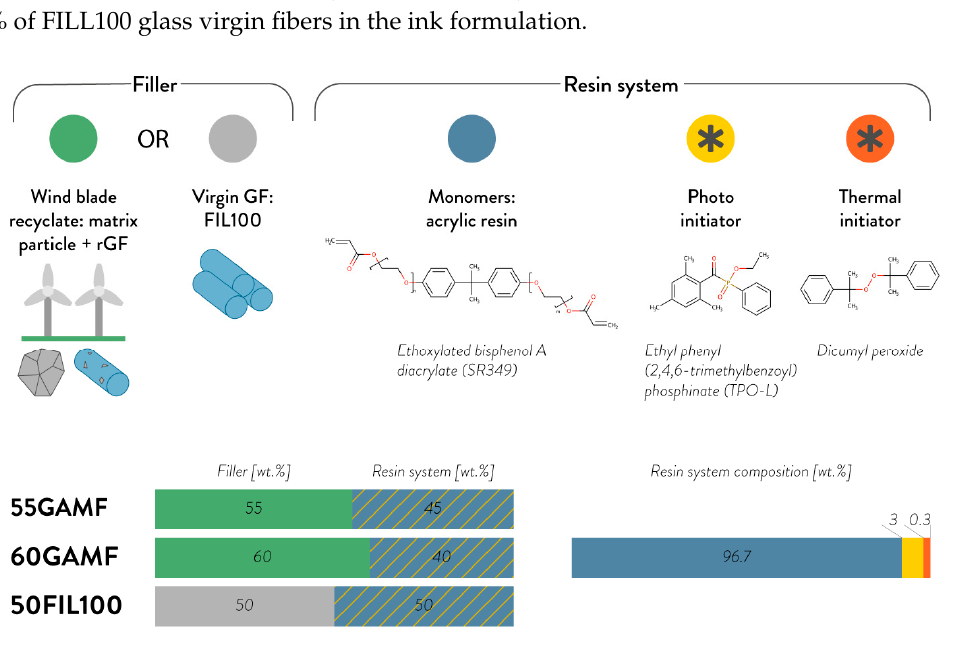
Figure 1. 3D Printable ink composition and percentages of the formulations used in this work.